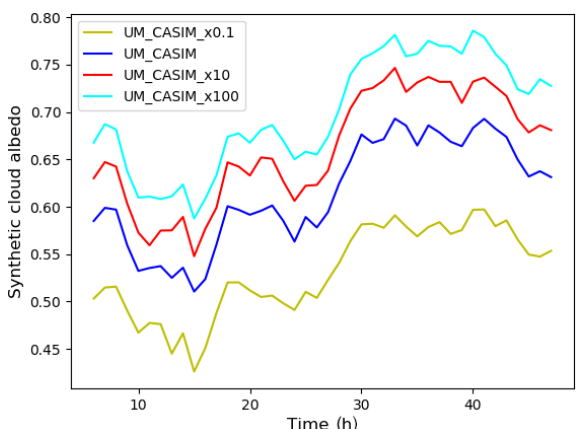
Figure 7. Time series of mean synthetic cloud albedo. This is calcu- lated for cloudy columns only using an estimate of the cloud optical depth, as shown in Eq. (1).